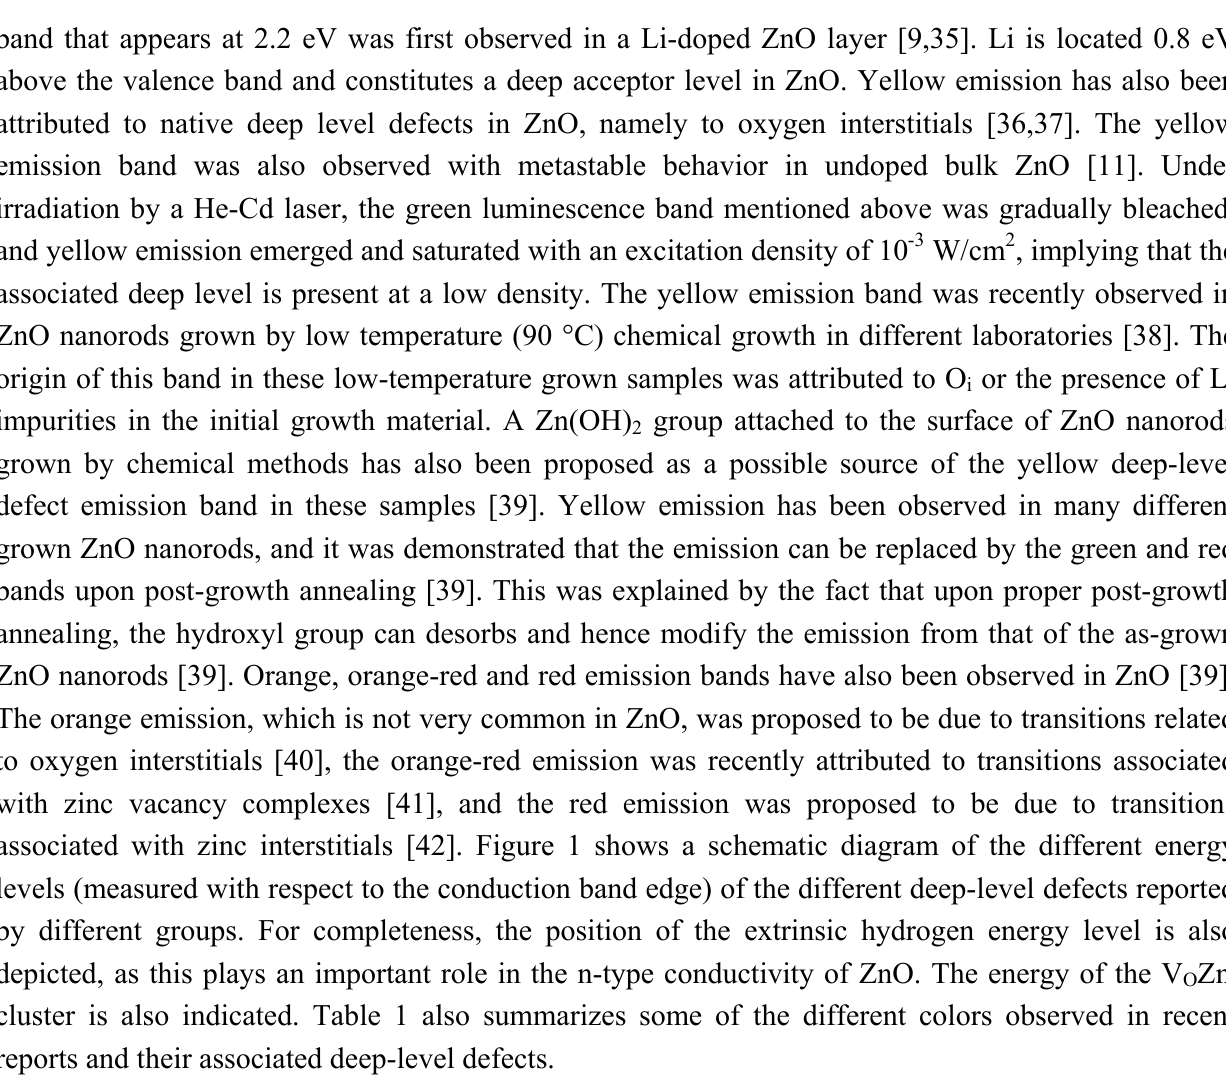
Figure 1. Energy levels of the different deep level defects in ZnO reported in the literature by different groups: (a) ref [54]. (b) ref. [43].(c) ref. [56]. (d) ref. [44]. (e) ref. [25]. (f)